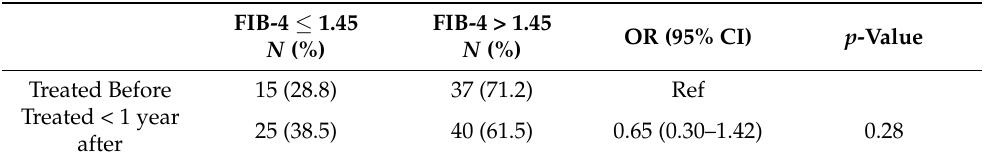
Table 3. Odds ratio and 95% interval of the association between treatment group and Fib-4 score <1.45 corresponding to little or minimal fibrosis or >1.45 indicating at least moderate fibrosis or greater. Odds ratio for Fib-4 score >1.45